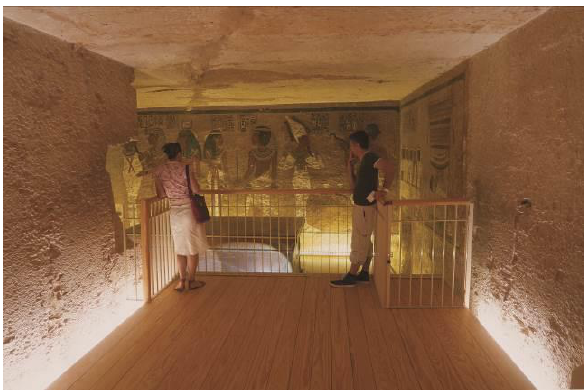
Figure 8. View of the antechamber looking north to the burial chamber in the replica tomb © J. Paul Getty Trust